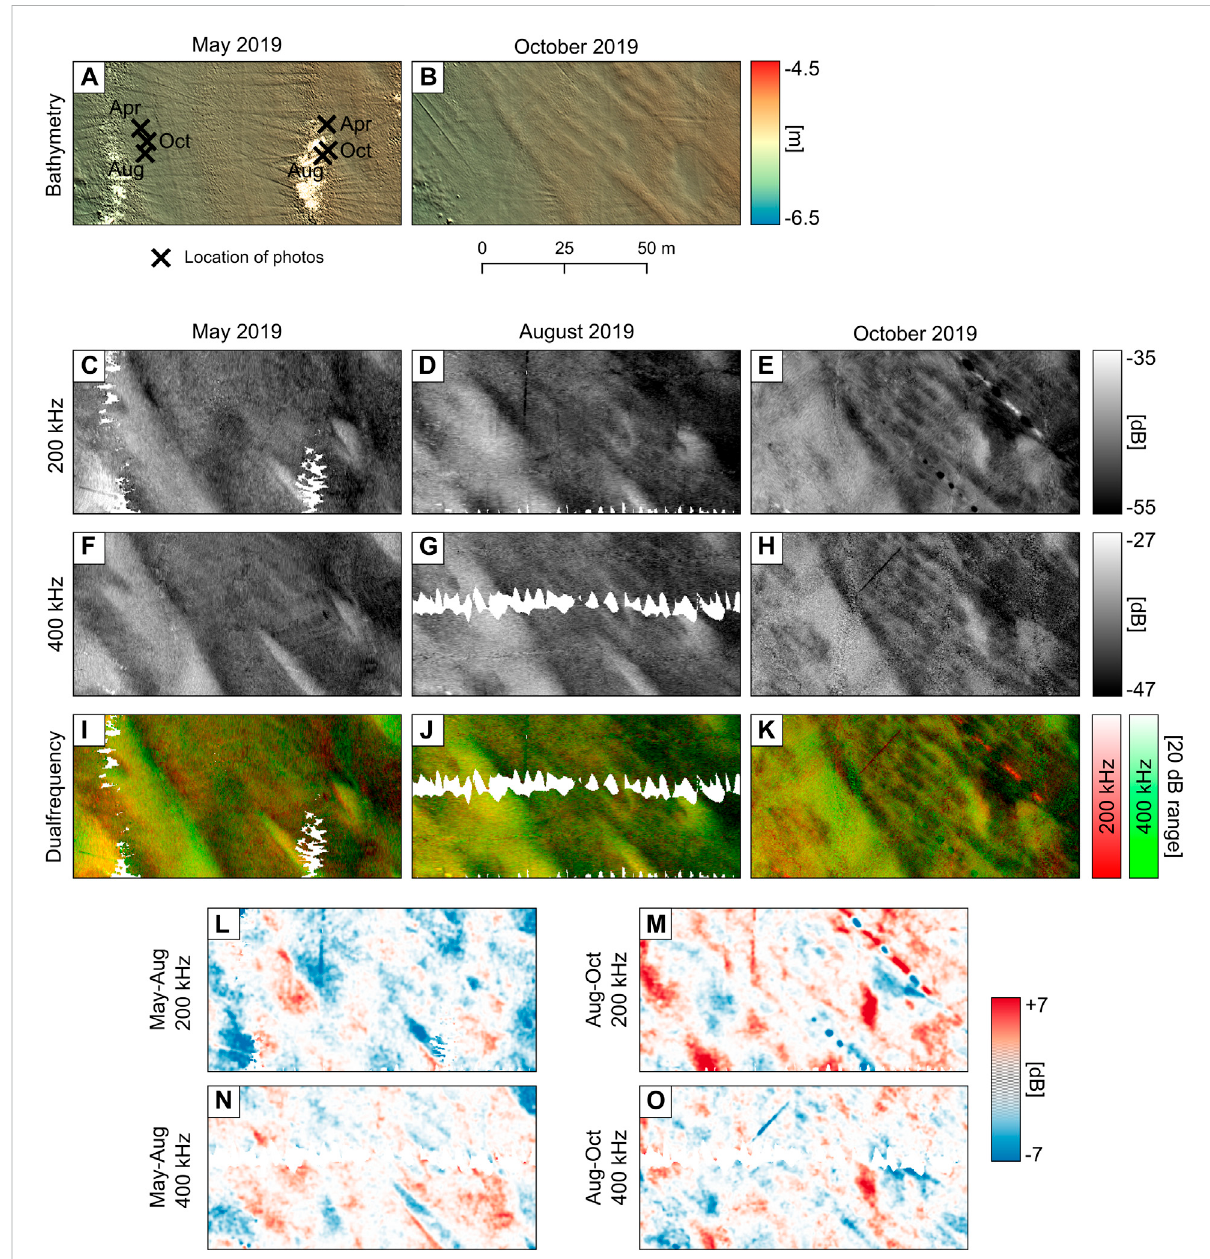
FIGURE 7 Detailed view of acoustic maps of the CSG facies (for location see Figure 2B). (A,B) Bathymetry in May (200 and 400 kHz combined) and October (400 kHz). The resolution is 0.25 m and a hillshade is added with sun azimuth of 35 ° and sun elevation of 20 ° . (C – E) Backscatter mosaic at 200 kHz frequency for May, August, and October 2019. (F – H) Backscatter mosaic at 400 kHz frequency for May, August and October 2019. (I – K) Dual-frequency backscatter mosaic for May, August, and October 2019. The 200 kHz frequency is assigned to the red color channel and 400 kHzassignedtothegreencolorchannel. (L,M) Differenceplotsofthe200 kHzbackscattermosaicswitha5celllowpass fi ltershowthechanges between May to August (L) and August to October (m). (N, O) Difference plots of the 400 kHz backscatter mosaics with a 5 cell lowpass fi lter show the changes between May to August (N) and August to October (O)